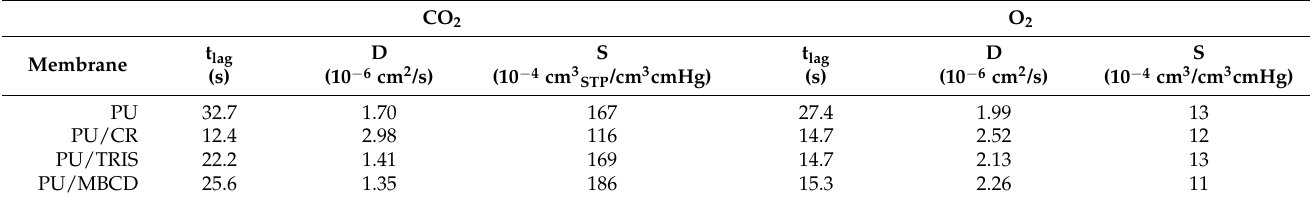
Table 4. Time lag (t lag ) values, diffusion coefficients (D), and solubility coefficients (S) obtained for the permeation of O 2 and CO 2 through the PU, PU/CR, PU/TRIS and PU/MBCD